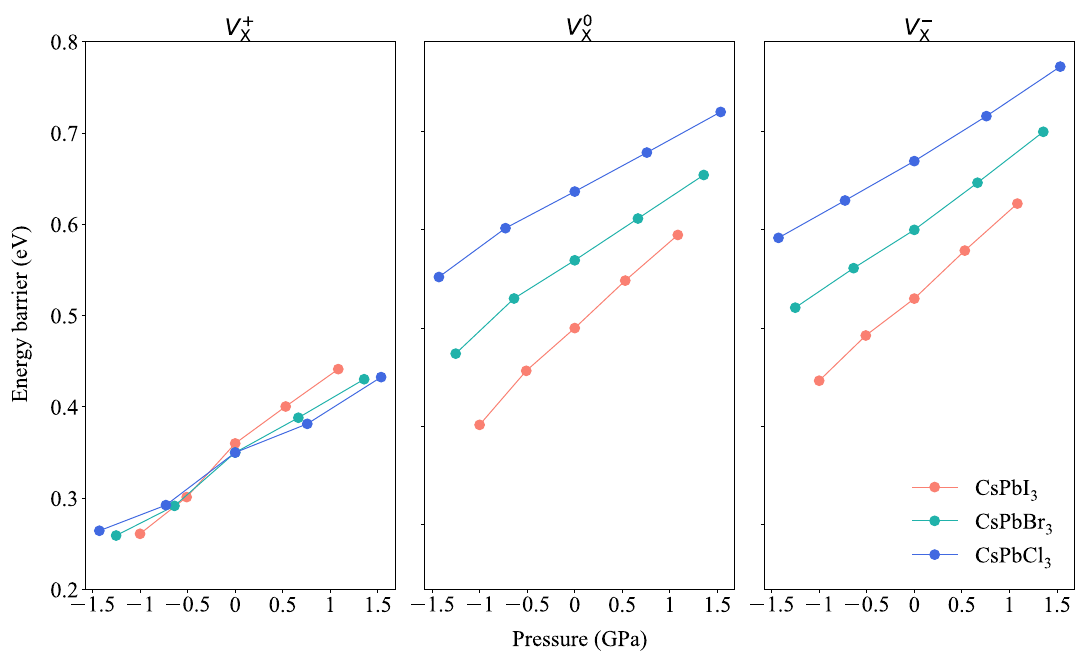
Fig. 4 Change in activation energy for halide diffusion in CsPbX pressure corresponding to a unit cell expansion. Points for Cl, Br and I are colored blue, green,